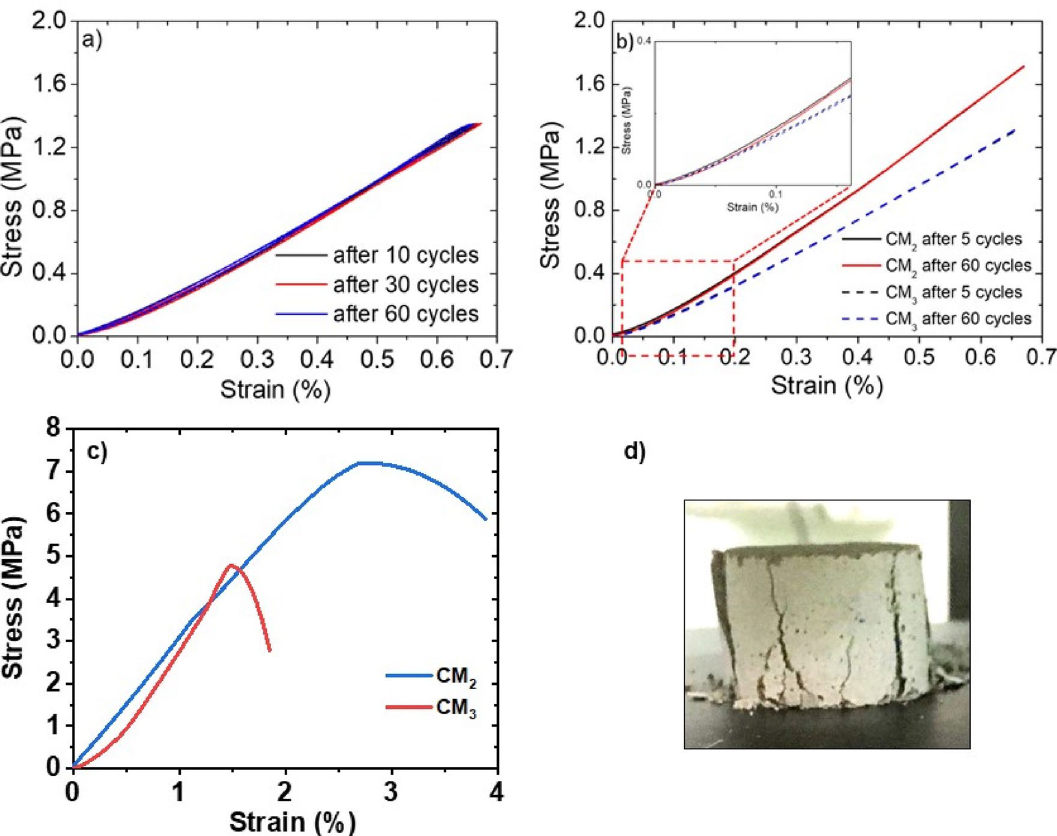
Figure 5. ( a ) Compressive stress–strain curves after 10, 30 and 60 cycles for CM 3 , ( b ) compressive stress–strain curves of CM 2 and CM 3 samples after 5 and 60 loading/unloading cycles; ( c ) compressive stress–strain curves of CM 2 and CM 3 samples until the breaking point (corresponding to the strain at which the testing machine was not able to control the crack propagation), ( d ) picture of CM 2 sample at breaking